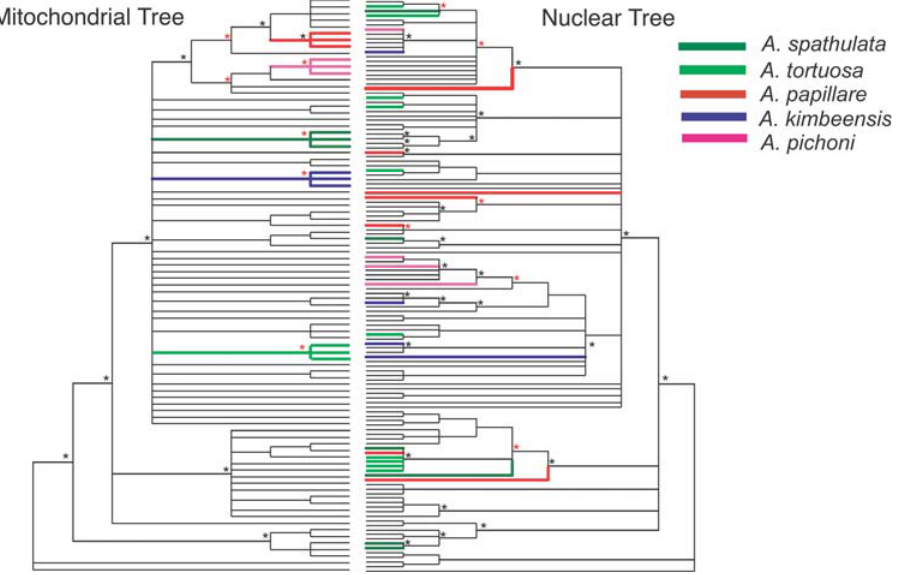
Figure 5. Comparison of nuclear and mitochondrial phylogenies. Asterisks indicate posterior probability values of 100% (black) or . 70% (red); for clarity, asterisks are shown only at nodes affecting the positions of sequences from A. papillare , A. pichoni , A. kimbeensis , A. spathulata and A. tortuosa.